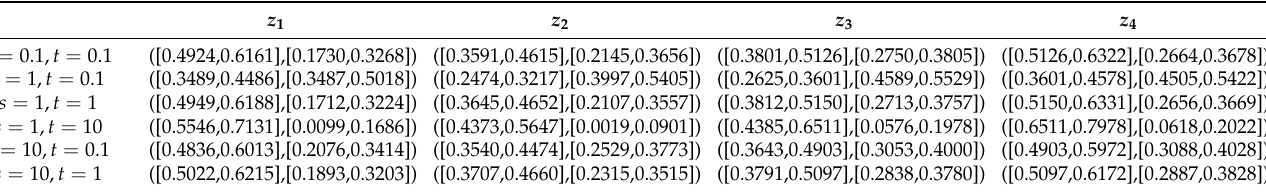
Table 2. The aggregated IIFNs for different s , t .